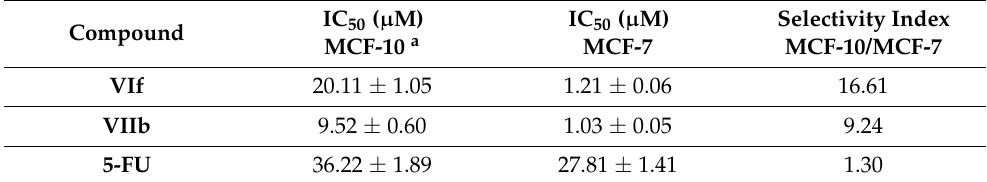
Table 2. IC 50 values ( µ M) of the most cytotoxic compounds ( VIf and VIIb ) against MCF-10A cell line and their selectivity indices.